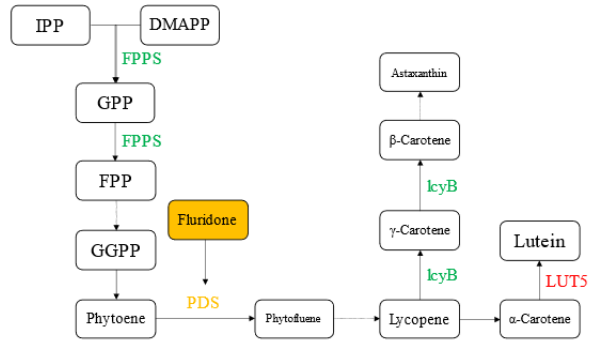
Figure 8. Represents the names of some metabolites and enzymes in the carotenoid metabolic pathway of Haematococcus pluvialis . Green indicates downregulation of related enzyme genes, red indicates upregulation, yellow indicates the possible action site of fluridone, and dashed arrows indicate omitted metabolic processes.